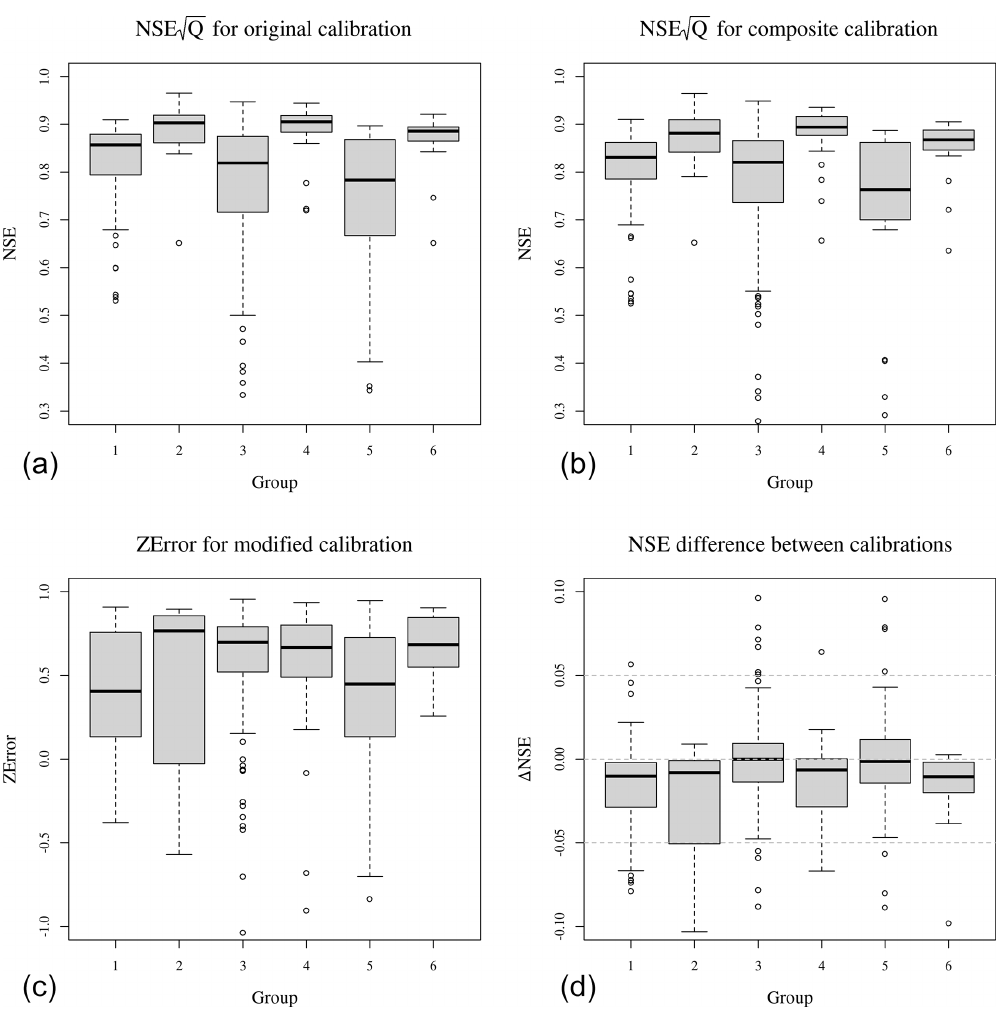
Figure 17. Distributions of the results for groups detailed in Table 3. From (a) to (d) : value of the Nash–Sutcliffe efficiency for each pair, computed on the square root of the streamflow, for the original calibration, i.e. α = 0; value of the Nash–Sutcliffe efficiency for each pair, computed on the square root of the streamflow, for the composite calibration with α = 0 . 16; value of the Z Error criterion for each pair for α = 0 . 16; difference in the NSEs obtained with the composite and the original calibration